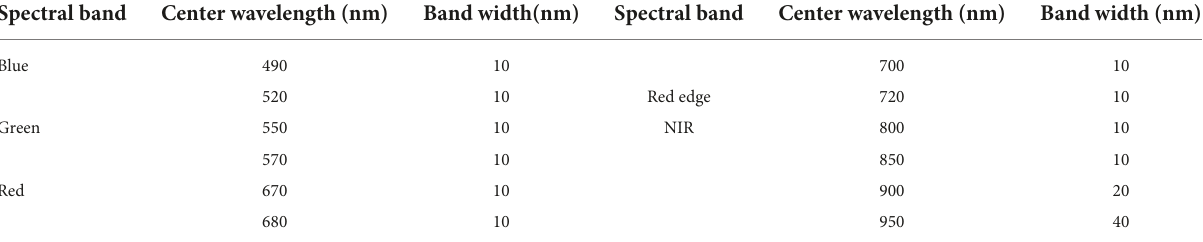
TABLE 2 Bandwidth of the 12 bands of the Mini-MCA camera.